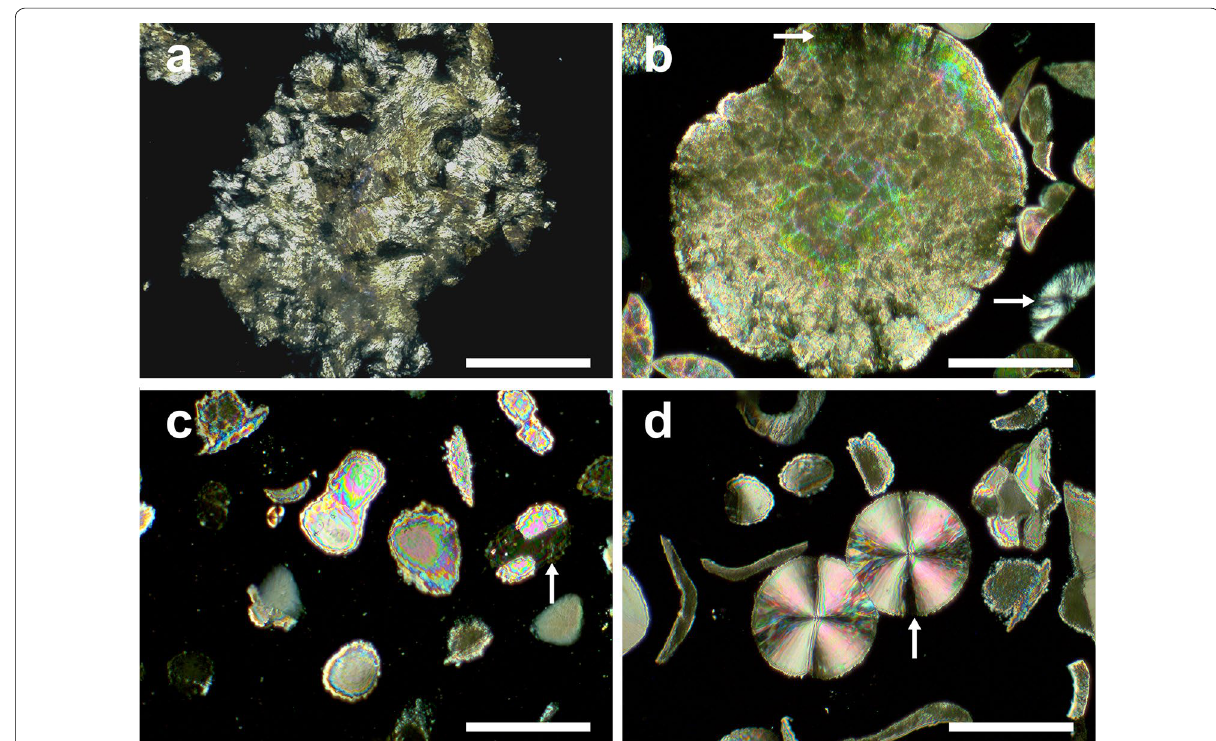
Fig. 2 Thin section micrographs of mineral grow composites produced in presence of Bacillus subtilis at different condition. a BCC‑GLY, b BCC‑GLC, c BCC‑LAC, and d BCC‑ACE. Images were acquired with polarized and analyzed light. They show size, shape, and optical properties of biogenetic crystals from diverse media. Arrows symbol show a key optical property, of light extinction (see result and discussion text). Scale bar: 100 μm